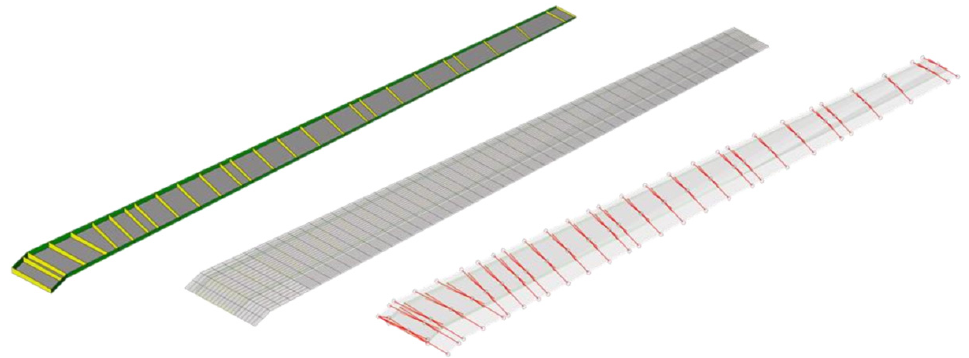
Figure 3. NASTRAN models used in Step 2 of the optimization workflow—structural FE model, aerodynamic DLM model, and coupled aeroelastic splining model.